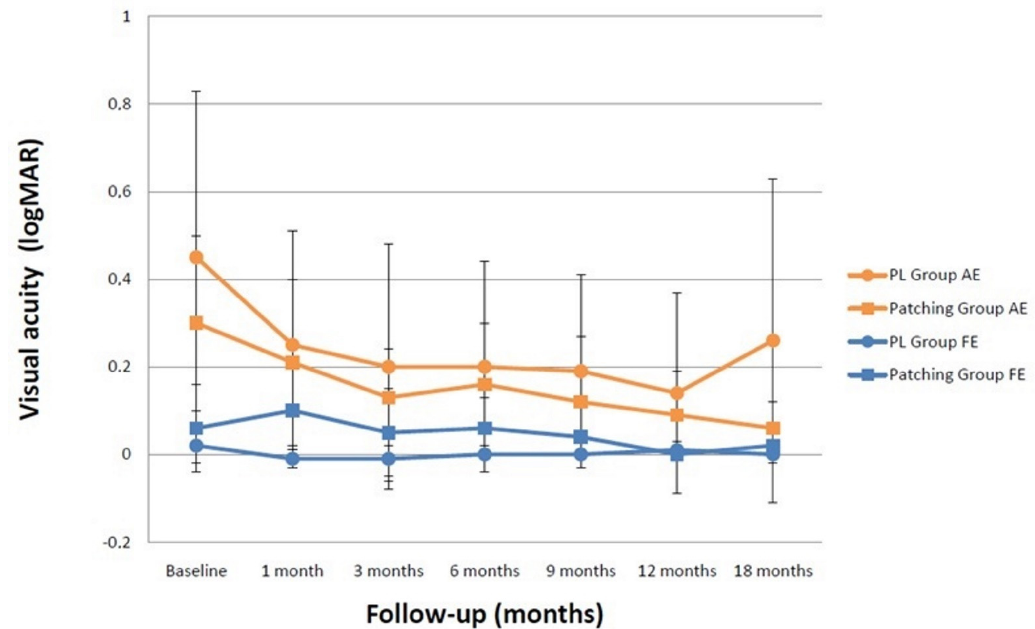
Figure 3. Visual acuity of perceptual learning group (PL Group) and patching group. Blue lines are for fellow eyes (FE) and orange lines for amblyopic eyes (AE).